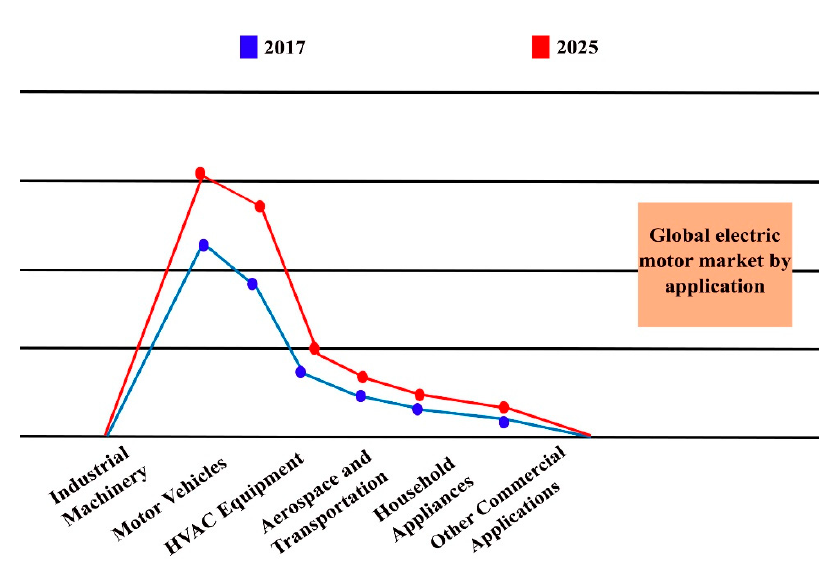
Figure 2. Global electric motor market by application [2].